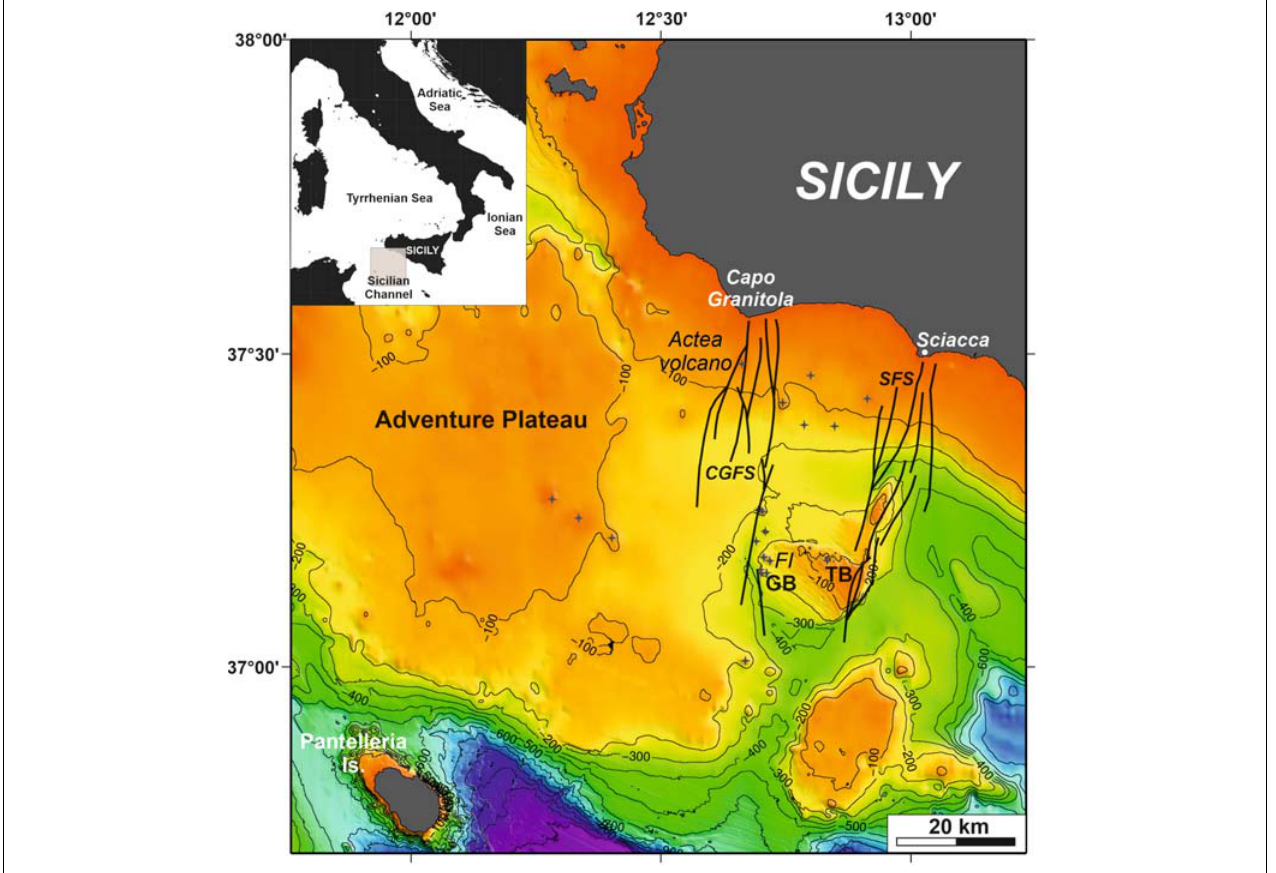
FIGURE 1 | Bathymetric map of the NW sector of the Sicilian Channel (data taken from the EMODnet portal, https://portal.emodnet-bathymetry.eu/). Contours every 100 m. Brown stars indicate the location of the volcanic edifices. TB, Terrible Bank; GB, Graham Bank; FI, Ferdinandea island; CGFS, Capo Granitola Fault System; SFS, Sciacca Fault System. Box in the upper left corner indicates the location of the study